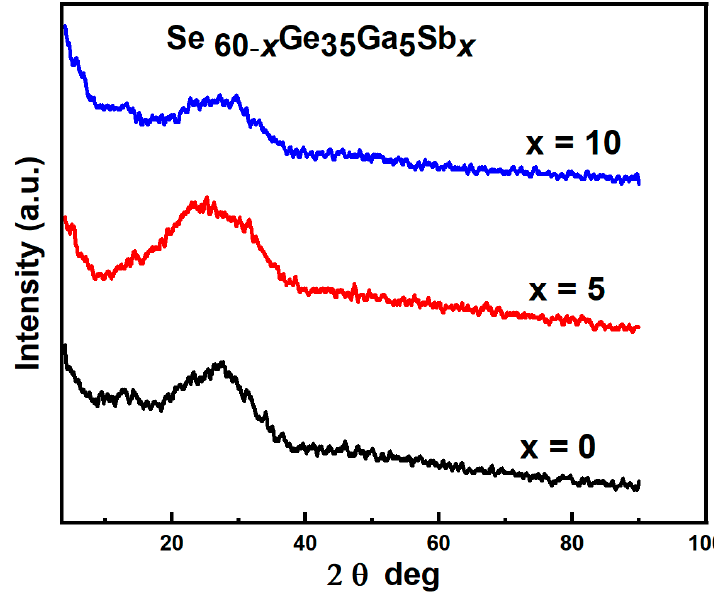
Figure 2. XRD patterns for Se 60 − x Ge 35 Ga 5 Sb x ( x = 0, 5, and 10 at. %) thin